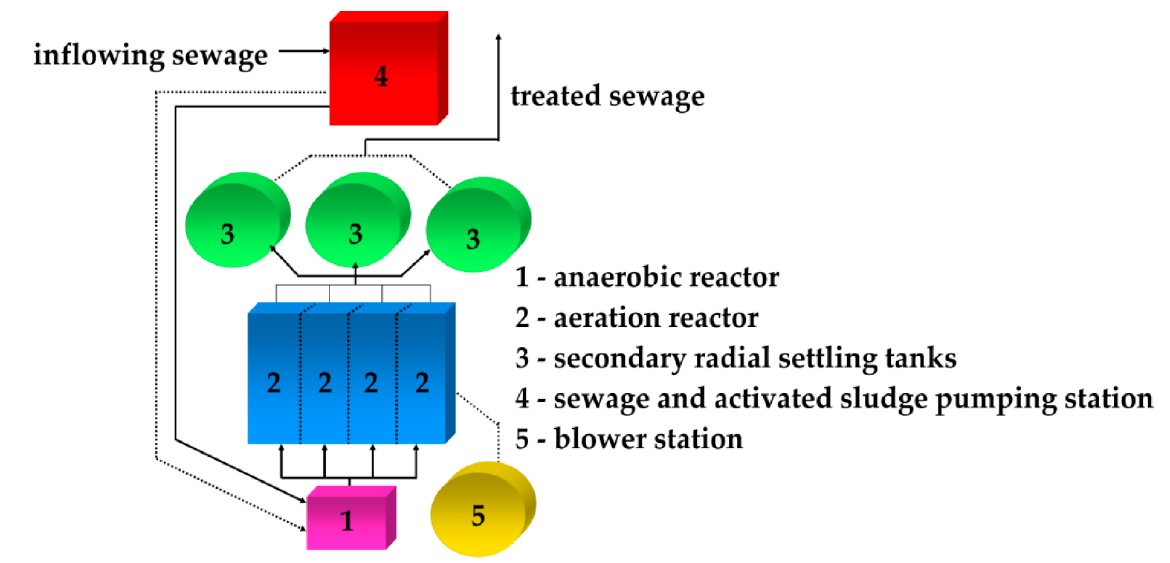
Figure 1. Diagram of the biological sewage treatment system in the Municipal and Industrial Wastewater Treatment Plant in O ś wi ę cim, Poland.